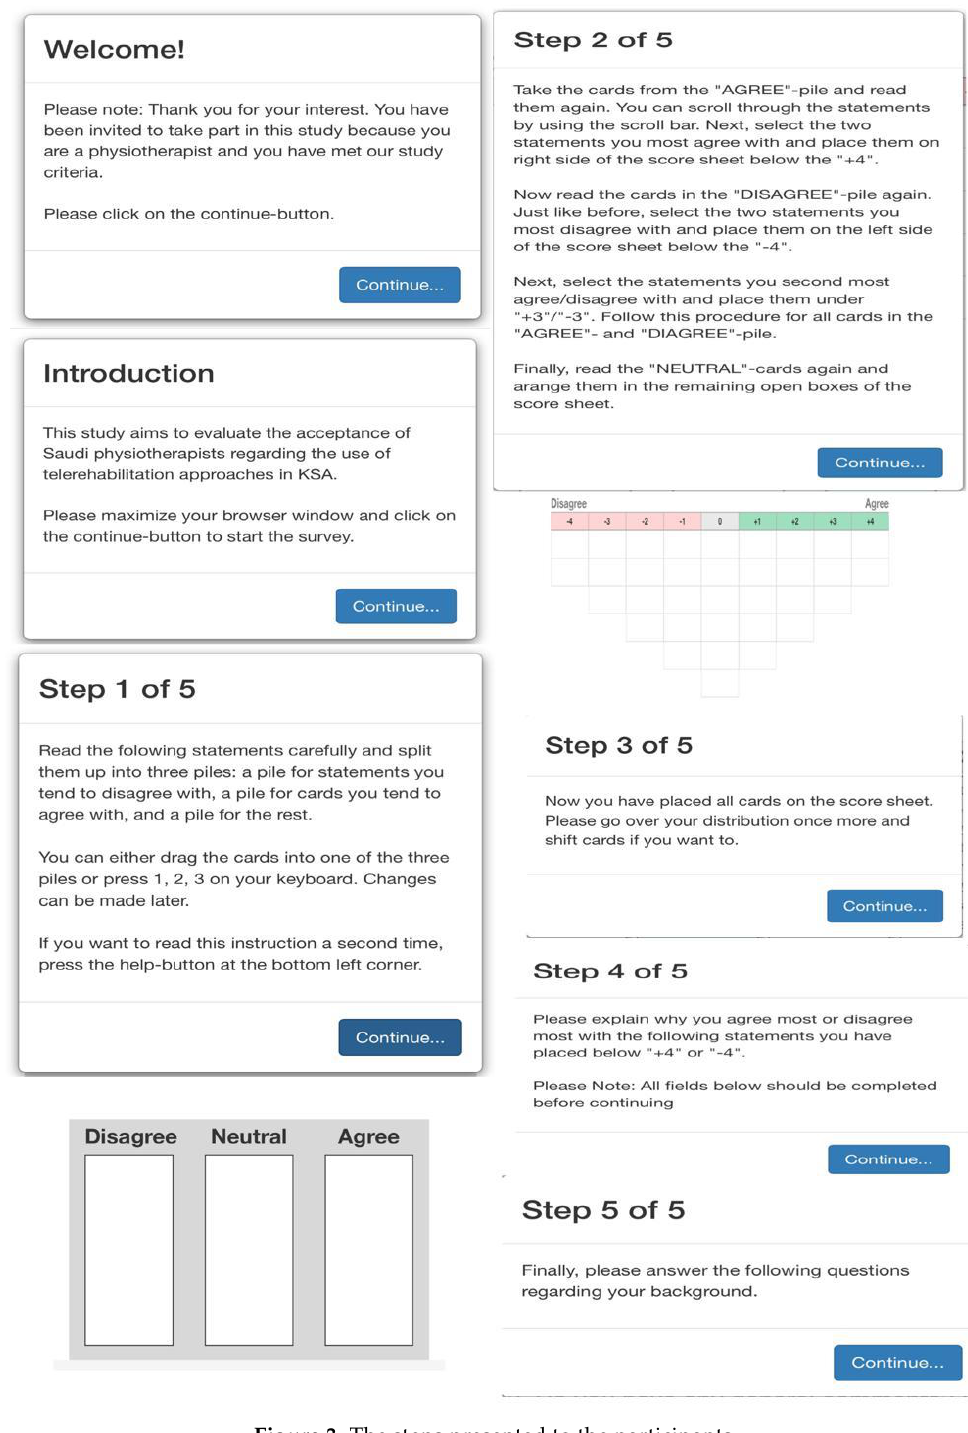
Figure 3. The steps presented to the participants .